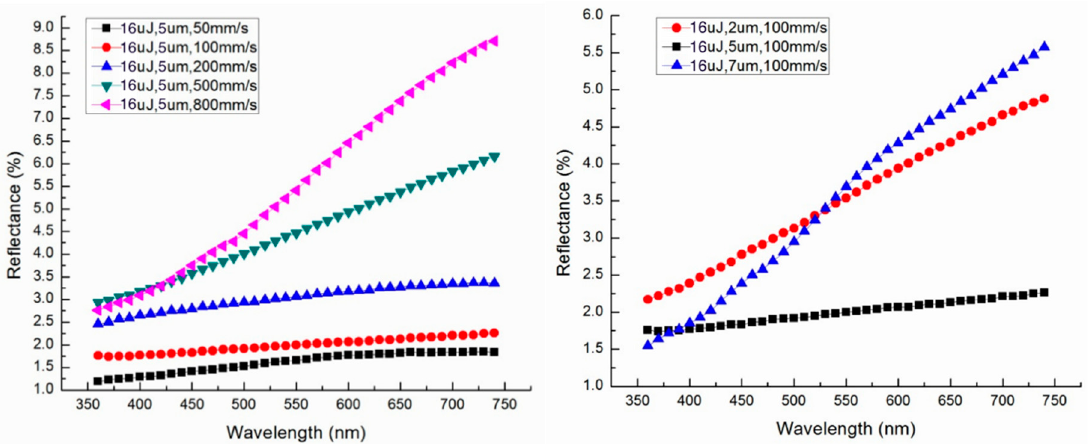
Figure 10. Reflectance as a result of various scanning speeds (left) and pitches (right).